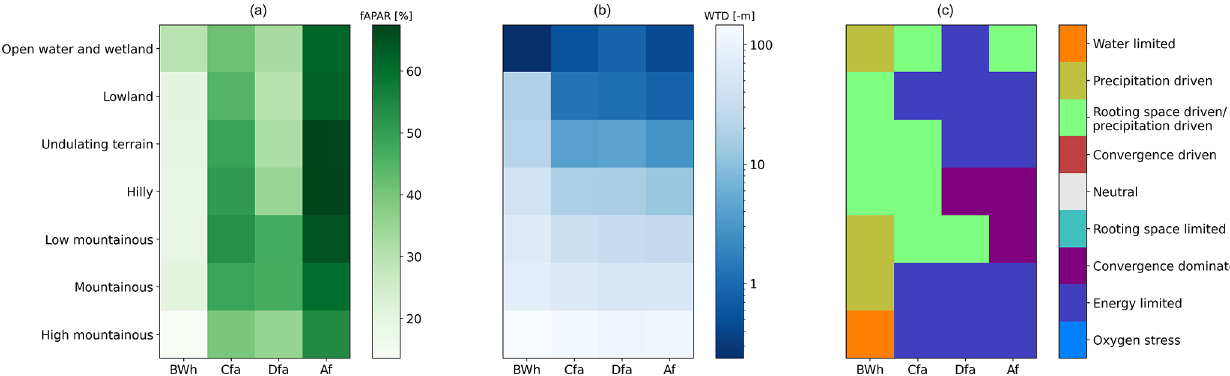
Figure 6. Distribution of average ecohydrological class as a function of landscape position and climate. This figure shows a subset of the Köppen–Geiger climates for clarity, namely arid (BWh), temperate (Cfa), continental (Dfa), and tropical (Af). For an extended version containing all the climates, see Figs. S24, S25 and S26. (a) Mean fAPAR, (b) mean water table depth and (c) prevalent ecohydrological class (after removing the cells in the neutral class). In Fig. S27 the full distribution of the ecohydrological classes within the selected climates is